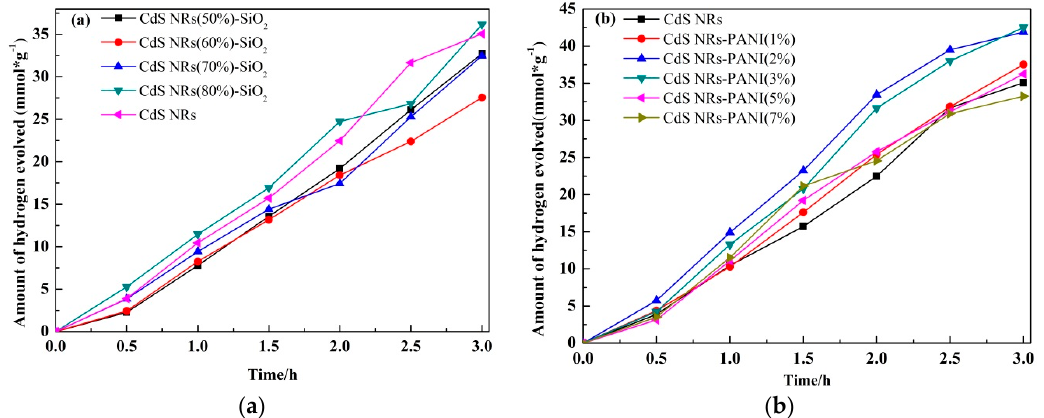
Figure 9. Photocatalytic hydrogen production activities of CdS NRs-SiO 2 hydrogel with different proportions ( a ) and CdS-PANI binary composites with different ratios ( b ).